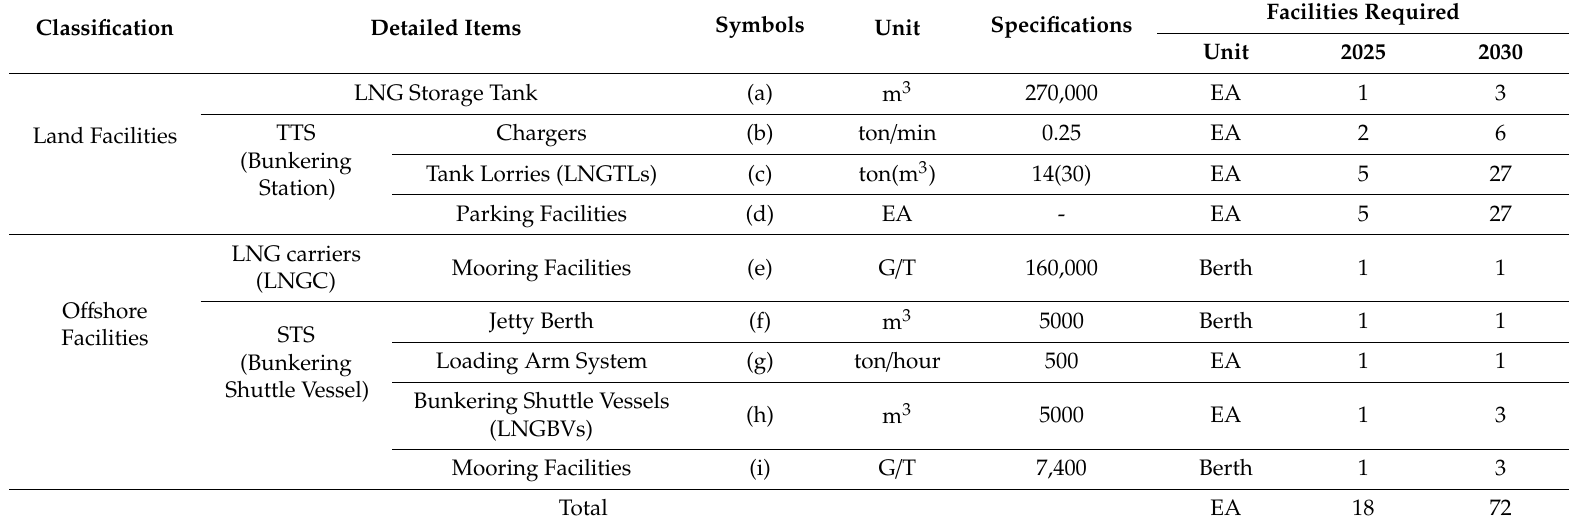
Table 20. Summary of the Results of Estimating the Size of LNG Bunkering Facility in Busan